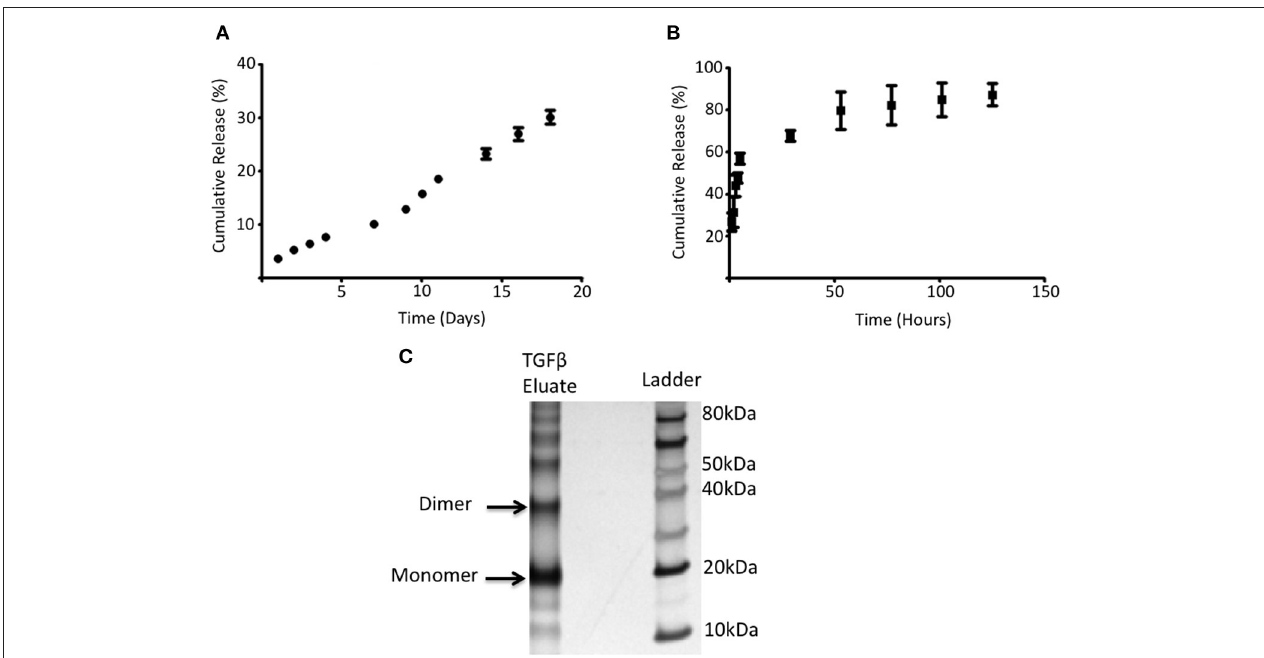
FIGURE 2 | RA and adsorbed protein release from PLGA-Ni microparticles. (A) The rate of RA release was determined by UV absorption and shown as cumulative release (% of starting amount) over time. (B) 5mg of PLGA-Ni particles with adsorbed His-tagged GFP was incubated in pH 8 Tris buffer at 37 ◦ C for 5 days. Free His-tagged GFP was measured with a fluorescent spectrometer ( λ = 508nm) at the indicated time points and the amount of free protein is shown as cumulative release (% of starting amount) over time. (C) Eluate from TGF β 1-adsorbed PLGA-Ni microparticles contains monomers, dimers, and higher order multimers of TGF β